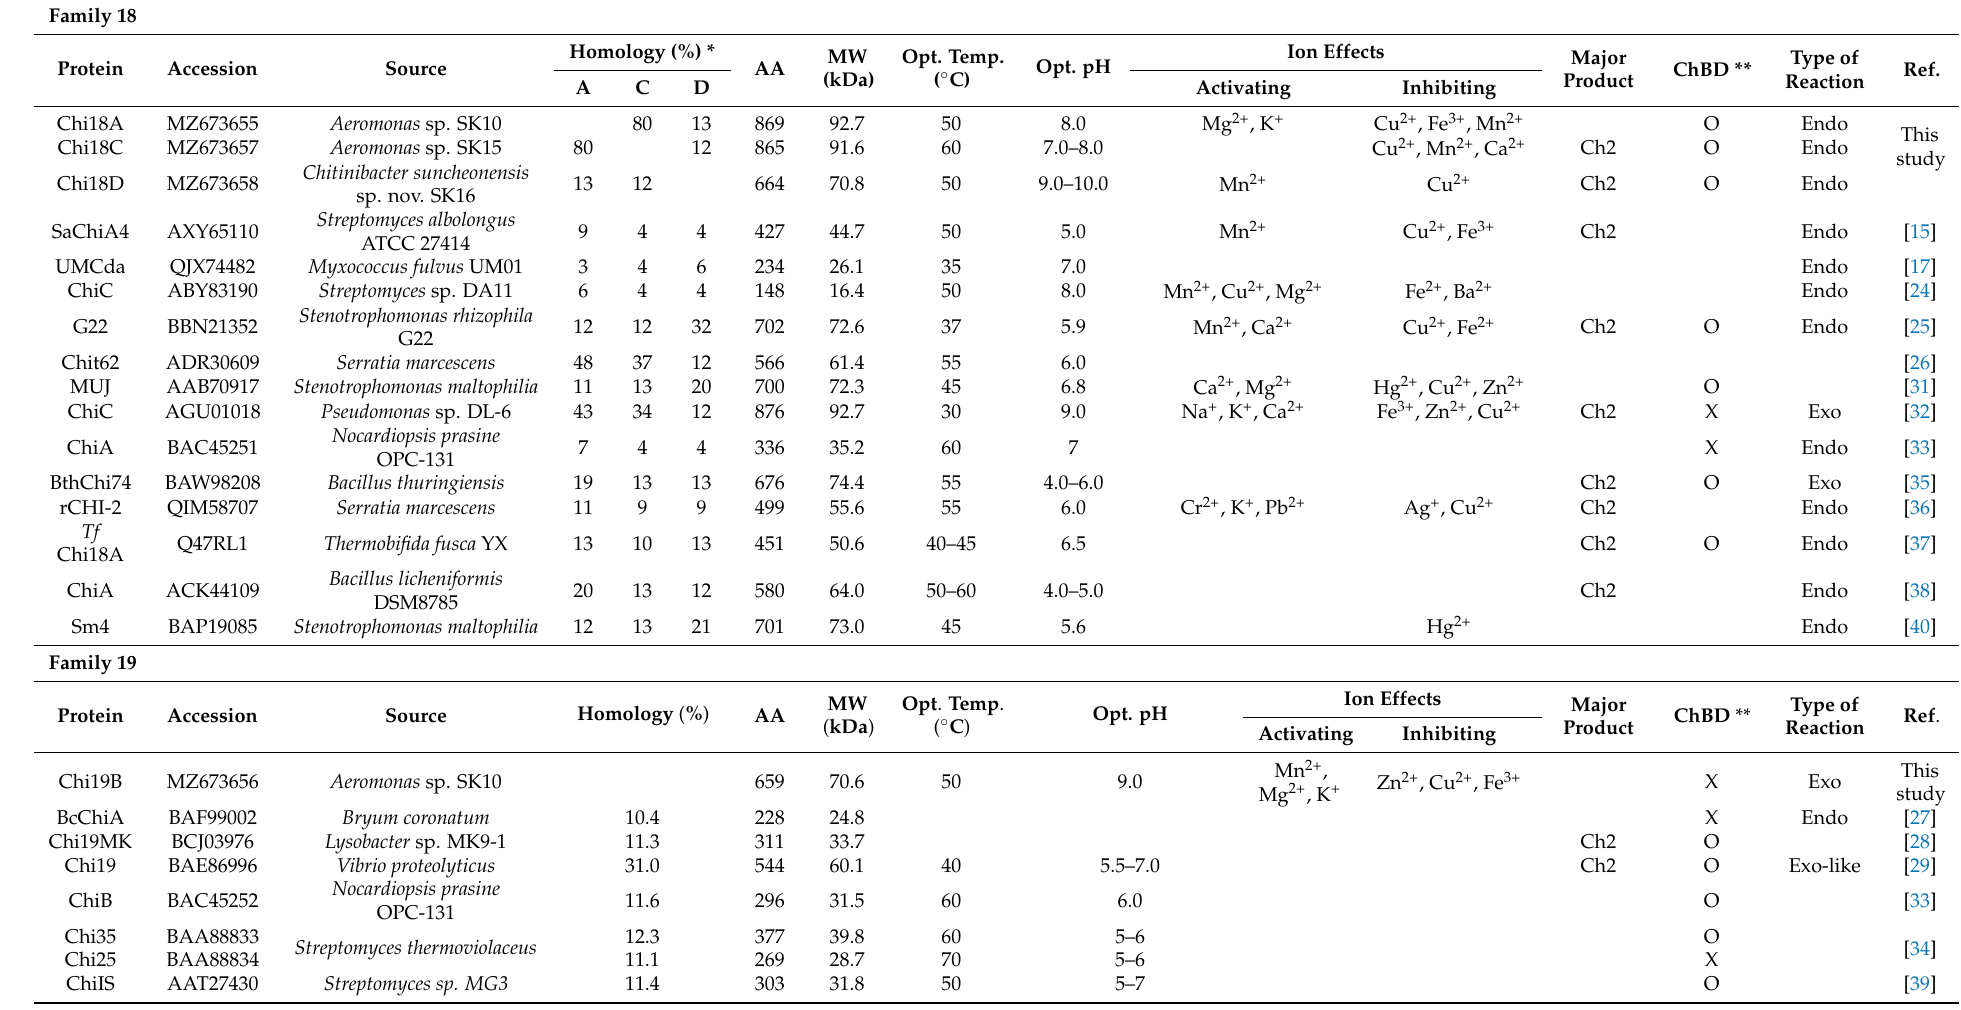
Table 2. Comparison of Chi18A, Chi19B, Chi18C, and Chi18D with other characterized